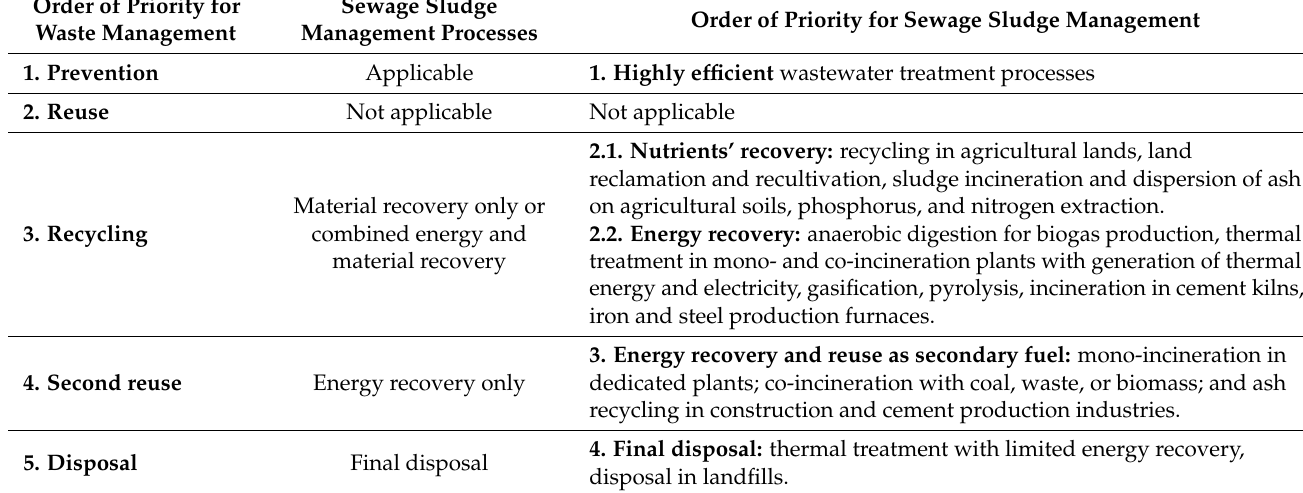
Table 2. Order of priority for the management of sewage sludge waste within the legislative frame- works of sustainable products and circular